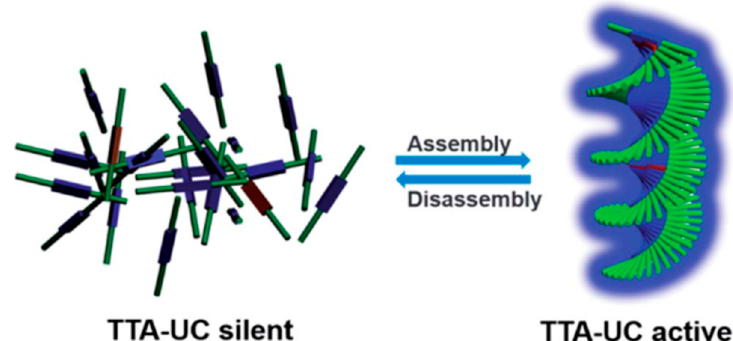
Figure 5. Schematic illustration of the self-assembly-induced TTA-UC. Acceptor molecules spontaneously co-assemble with donor molecules to enable reversible thermal switching of TTA-UC. Adopted with permission from [38]. Copyright 2017 Royal Society of Chemistry.